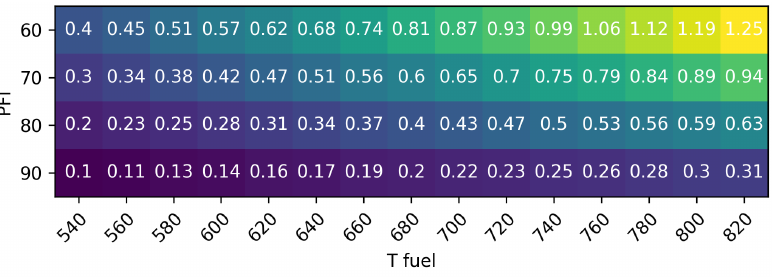
Figure 10. Heat map of the efficiency loss (%) due to fuel heating as a function of the port fuel fraction and the direct injected fuel temperature (in K).